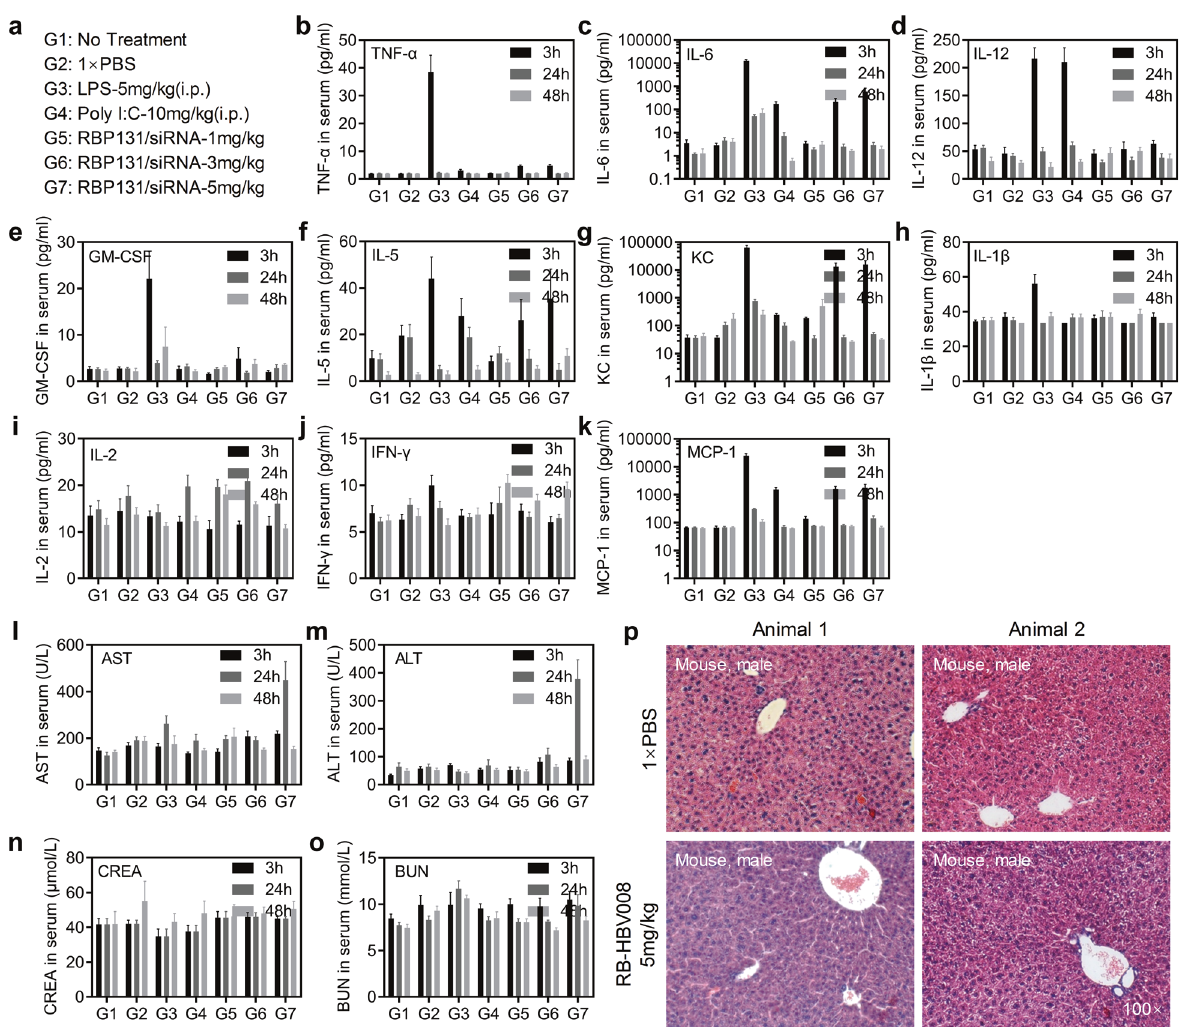
(Lipopolysaccharides (LPS, G3) and poly I: C (G4)) were included in the assay. b – k Cytokine concentrations in serums were collected at 3, 24, and 48 h post-administration. Ten cytokines including TNF- α , IFN- γ , IL-1 β , IL-2, IL-5, IL-6, IL-12(p70), MCP-1, KC, GM-CSF were analyzed with Luminex ® assay. l – o Levels of AST, ALT, CREA, and BUN in serums of the mice received various treatments at 3, 24, and 48 h. p Histological analysis of liver tissue sections prepared from the mice receiving the treatments of PBS or RB-HBV008 at 5.0 mg/kg. Data were shown